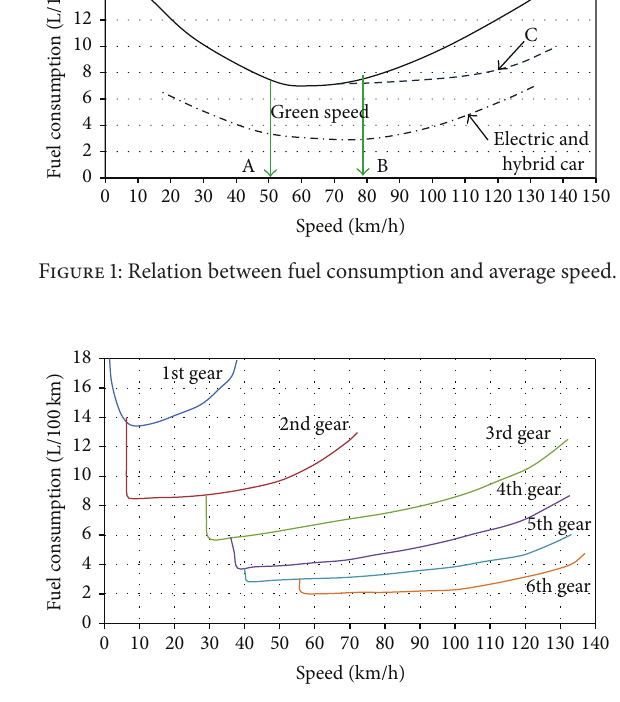
Figure 2: Relation between fuel consumption and gear change of a manual driving